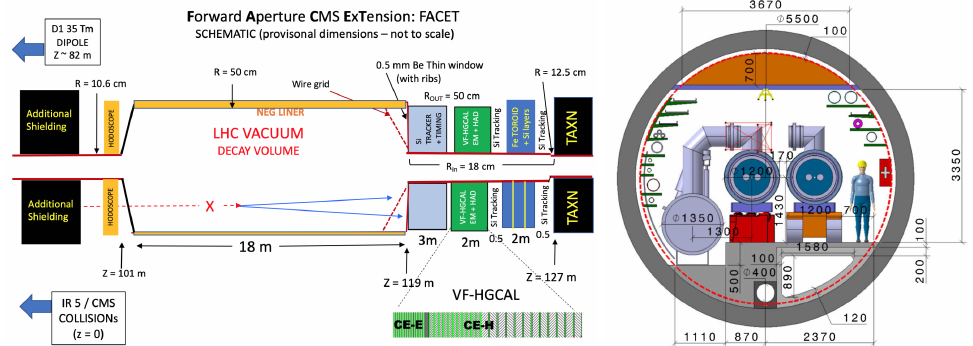
Figure 4 . Left: layout of the FACET detector at LHC from [27]. A section of the proton beam pipe is replaced with a larger pipe followed by detectors. Right: cross section of the FCC tunnel [34]. All distances are in mm. The minimal radius of the FACET decay volume is about 20 cm, to account for the beam